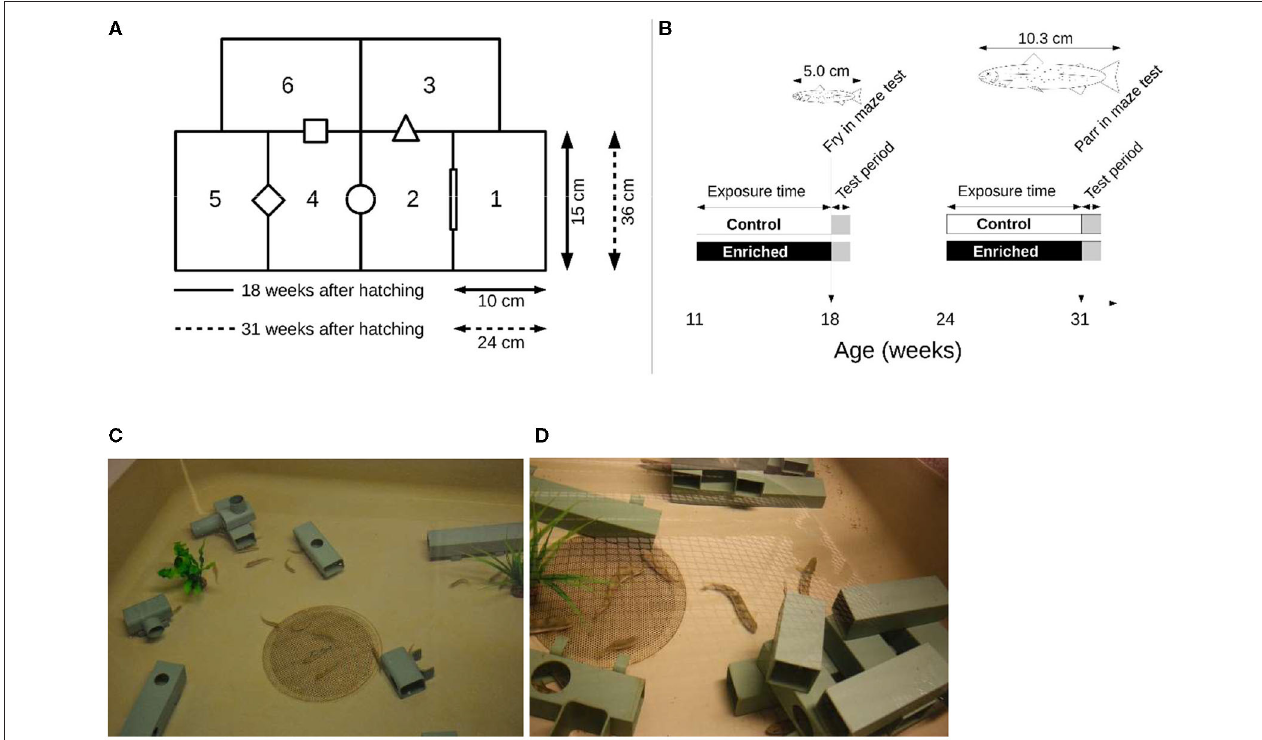
FIGURE 1 | (A) Schematic representation of the mazes used to test exploratory behavior and activity of juvenile Atlantic salmon reared 11–18 weeks after hatching in structurally enriched or control environments and those reared 24–31 weeks after hatching. The ratio between the fish length and the chamber size was the same for both groups. (B) The timeline of the experimental setup. The water of the chambers was connected via openings that differed in geometrical shape. (C) Structures used when rearing fry, and (D) Structures when rearing parr for 7 weeks in enriched environments. Control fish were reared in identical tanks but without structures.